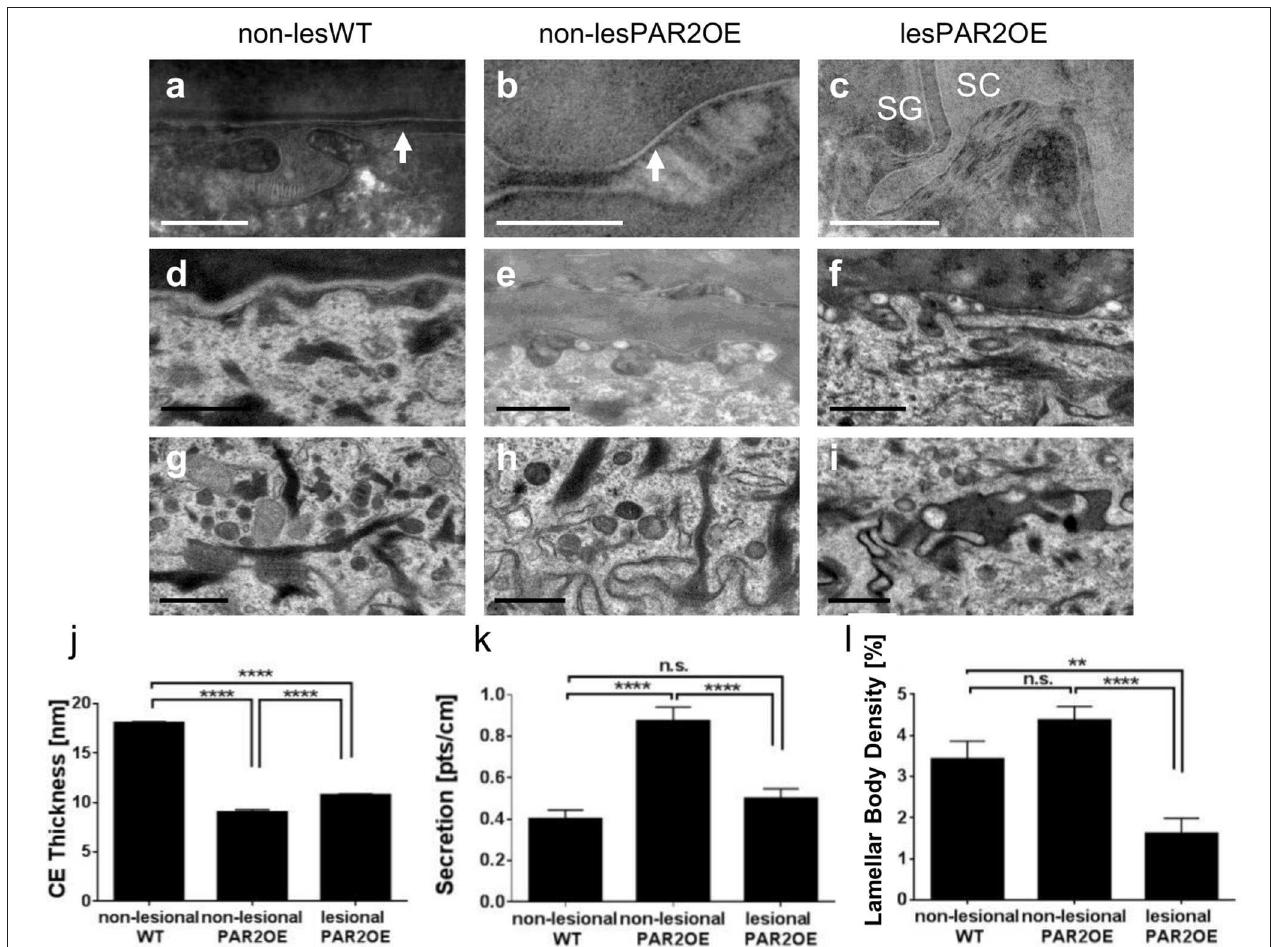
FIGURE 4 | Morphological analyses of subcellular compartments and components by electron microscopy in lesional and non-lesional skin of PAR2OE mice, and WT mice. (a–c,j) Arrow shows cornified envelope (CE) and quantification is shown in panel (j) ( n = 5). In each animal (age-matched 12-weeks-old mice), five pictures were analyzed and in four different locations CE thickness was measured (arrows point toward CE). Bars represent 0.2 µ m. SC, Stratum corneum; SG, Stratum granulosum. (d–f,k) Lamellar body secretion. Quantification of secreted lamellar bodies is shown in panel (k) , in each animal 10 pictures were analyzed ( n = 10). Bars represent 0.5 µ m. (g–i,l) Lamellar body density. Quantification ( n = 10) is shown in (l) . In each animal 10 pictures were taken and in each picture, two different areas were counted (when counting, three rotations of counting instrument, resulting in 60 area analyses). Bars represent 0.5 µ m. (j–l) Graphs show mean ± SEM. ** p < 0.01, **** p < 0.0001, n.s., not significant (unpaired Student’s t-